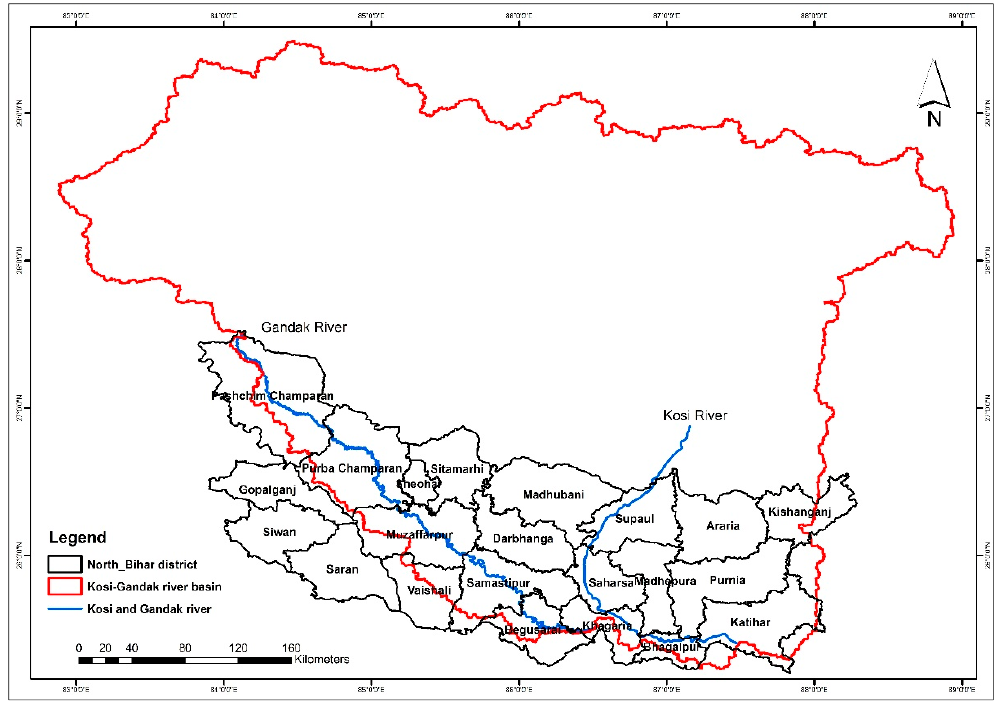
Figure 1. Location map of North Bihar region and Kosi Gandak river basin (red color boundary). The basin is situated in the northern part of India, Nepal, and Tibet. The major/minor tributaries of rivers Ganga, Kosi and Gandak have been overlaid over the 19 districts of the North Bihar region.